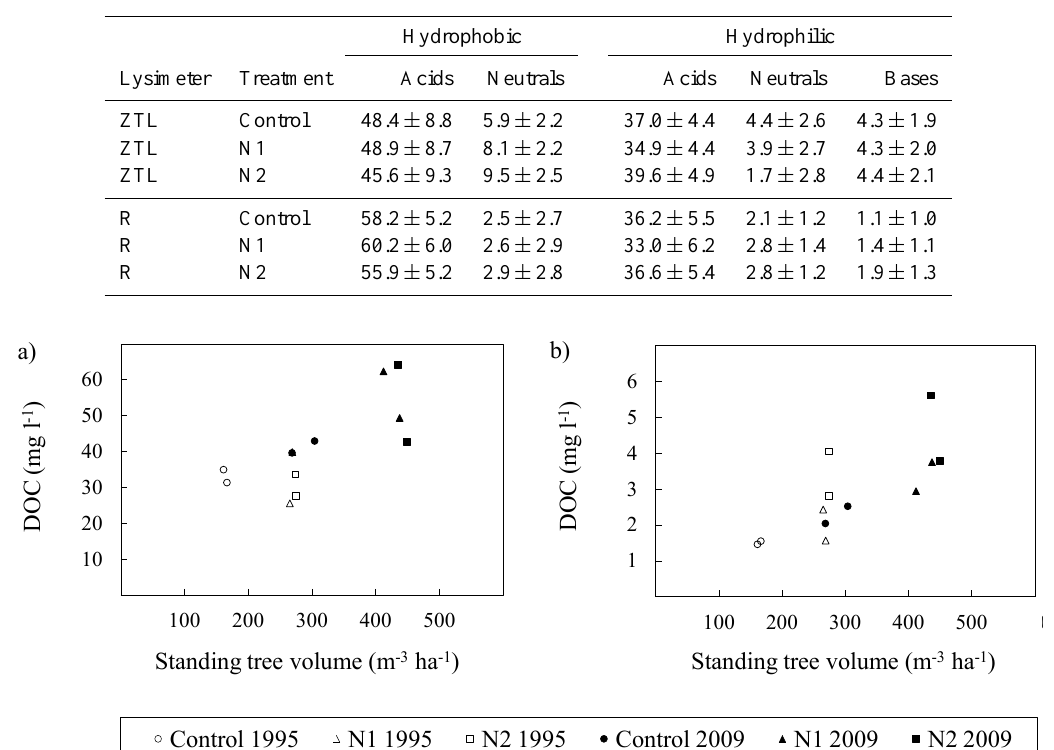
Table 5. Leenheer fractionation of O horizon leachates at Str˚asan experimental forest measured in 1995. Data from Zero tension lysimeters (ZTL) and rhizon lysimeters (R) are shown. Values are mean ± 95% confidence intervals ( n = 4). No effect of treatment was found at P = 0 . 05.